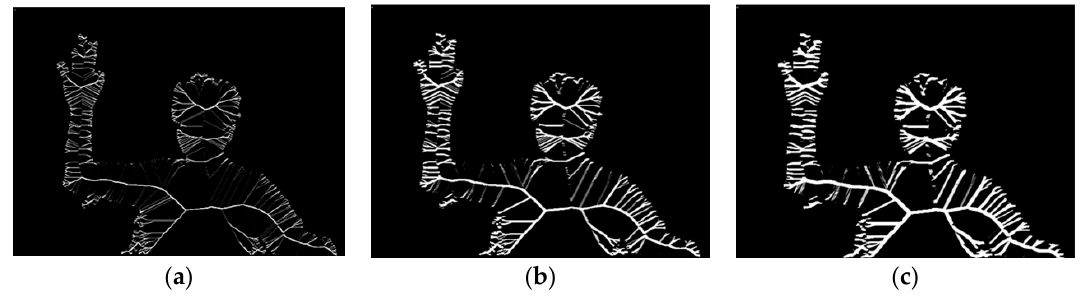
Figure 7. The effects of various convolution kernel processes to highlight the features of an image of the human body: ( a ) 3 × 3 convolution kernel, ( b ) 5 × 5 convolution kernel, and ( c ) 7 × 7 convolution kernel.